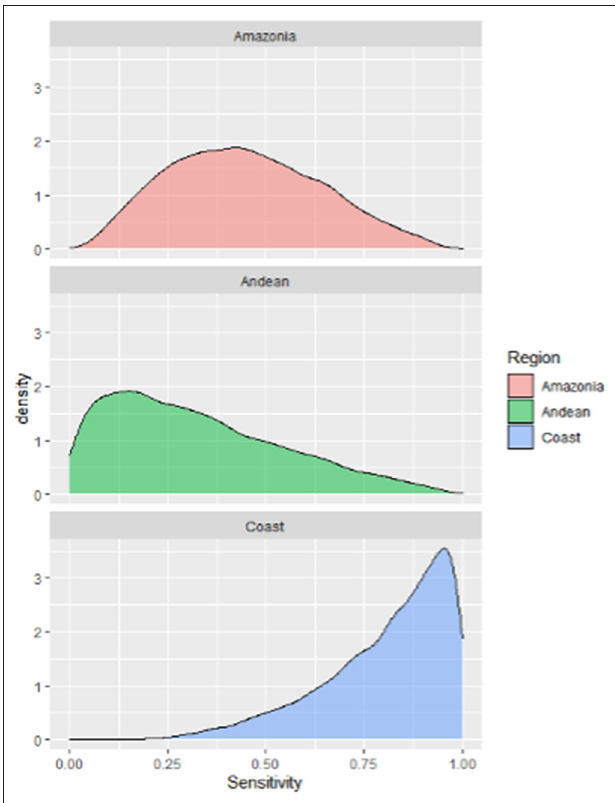
FIGURE 7 | Probability density distributions for the sensitivity of the current surveillance system for humans leptospirosis by different Ecuador geographical